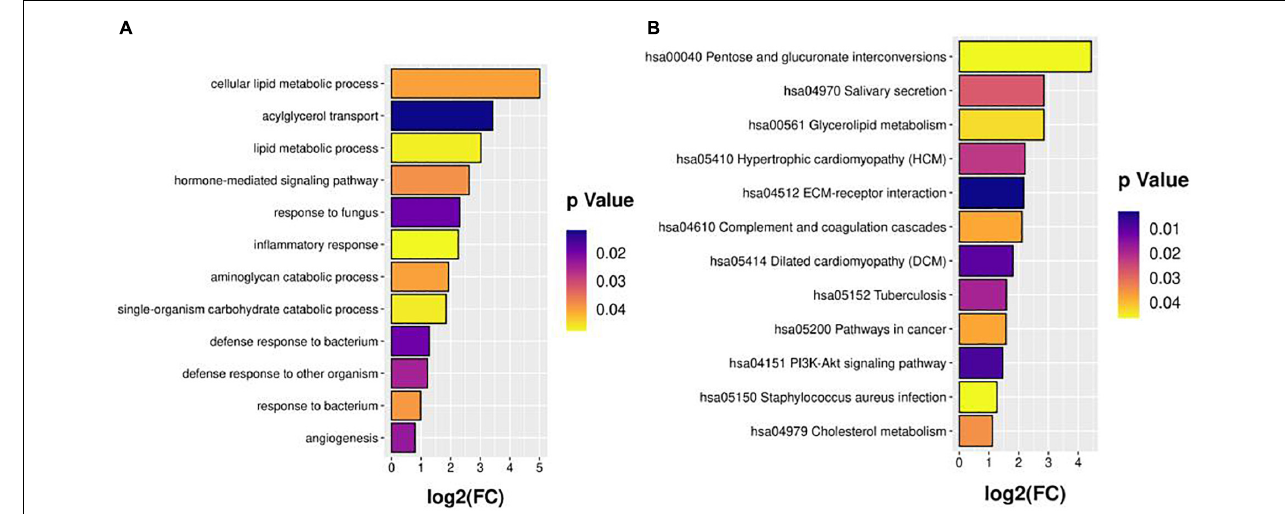
FIGURE 2 | GO (A) and KEGG (B) pathway enrichment analyses.